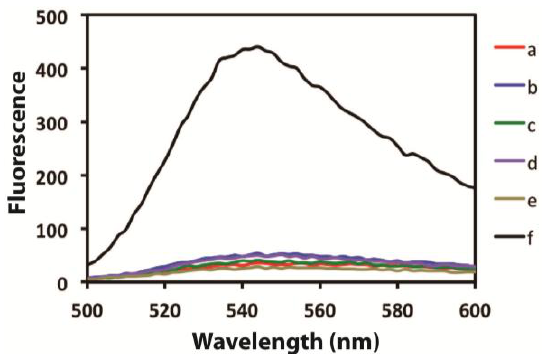
Figure 2. The validity of GO-based DNA biosensor for the amplification detection of target ATP: fluorescence spectrum of ( a ) GO-based DNA biosensor system consisting of target, polymerase and nicking enzyme in the absence of CPDNA; ( b ) GO-based DNA biosensor system consisting of CPDNA, polymerase and nicking enzyme in the absence of target; ( c ) GO-based DNA biosensor system consisting of target, CPDNA, nicking enzyme in the absence of polymerase; ( d ) same as ( c ), but it contains polymerase instead of nicking enzyme; ( e ) only contain GO-based DNA biosensor system; and ( f ) same as ( b ), but in the presence of target. The concentration of target ATP involved is 500